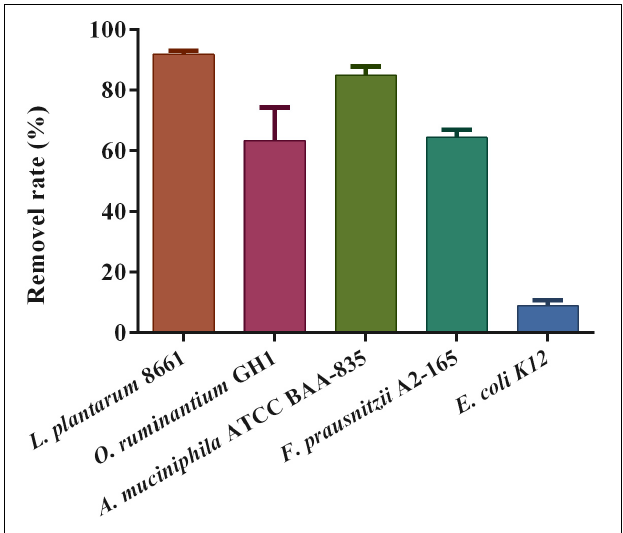
FIGURE 7 | Pb-binding abilities of specific strains ( n =